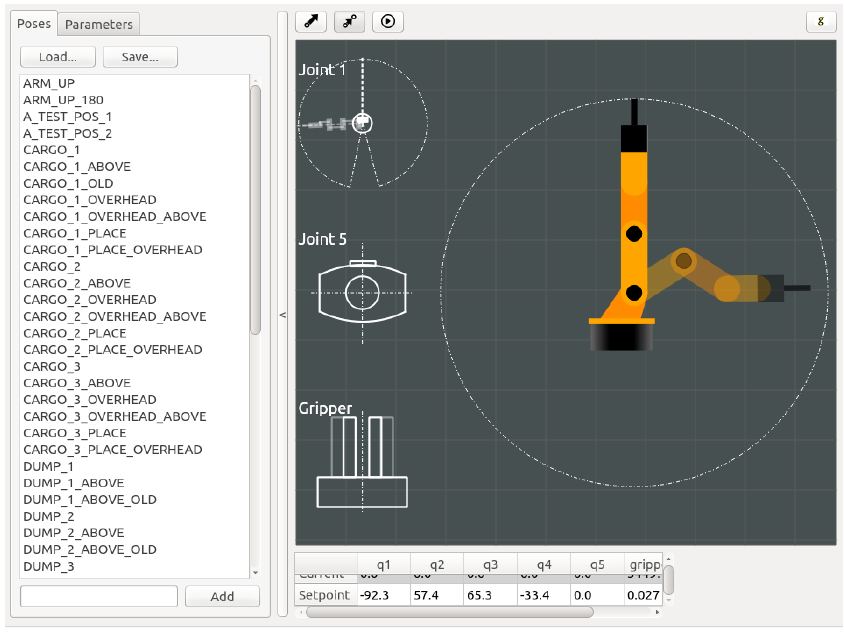
Figure 12. Graphical User Interface.